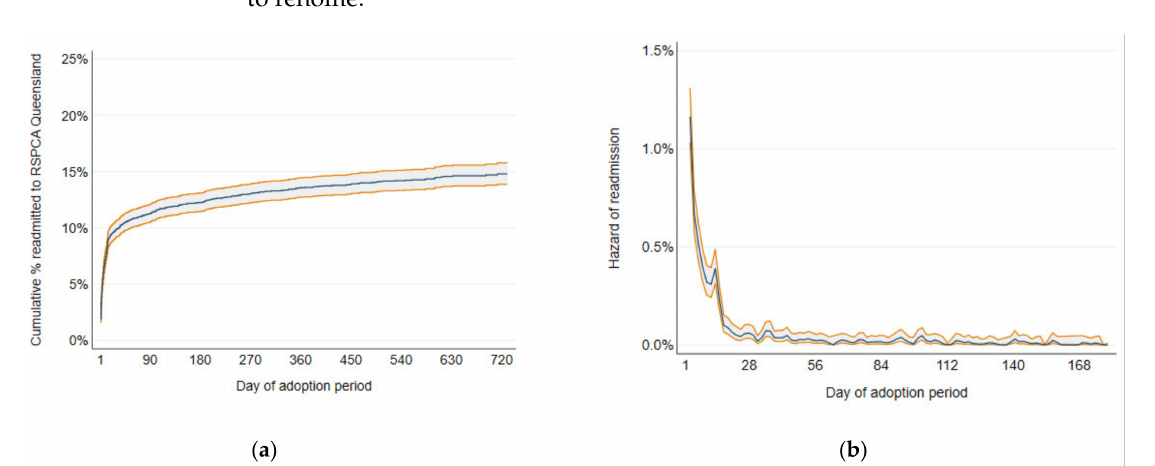
Figure 2. ( a ) Kaplan–Meier failure function for readmission to RSPCA Queensland of adopted dogs by day of adoption period; ( b ) Kaplan–Meier smoothed hazard estimates for readmission to RSPCA Queensland for dogs adopted from RSPCA Queensland in 2019 and 2020, by day of adoption period. Shaded bands indicate pointwise 95% confidence intervals.